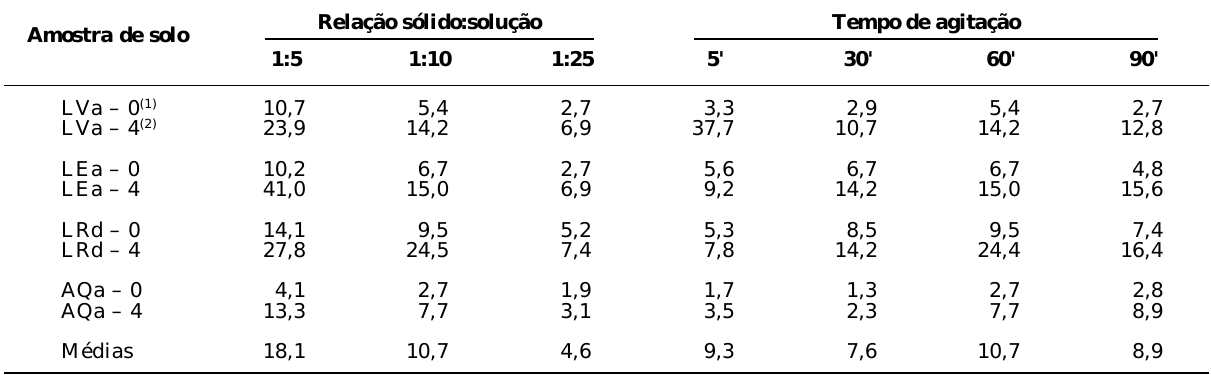
Quadro 4. Efeito da relação solo:solução e tempo de agitação sobre a extração do Si (mg dm -3 ) pelo método ácido acético 0,5 mol L -1